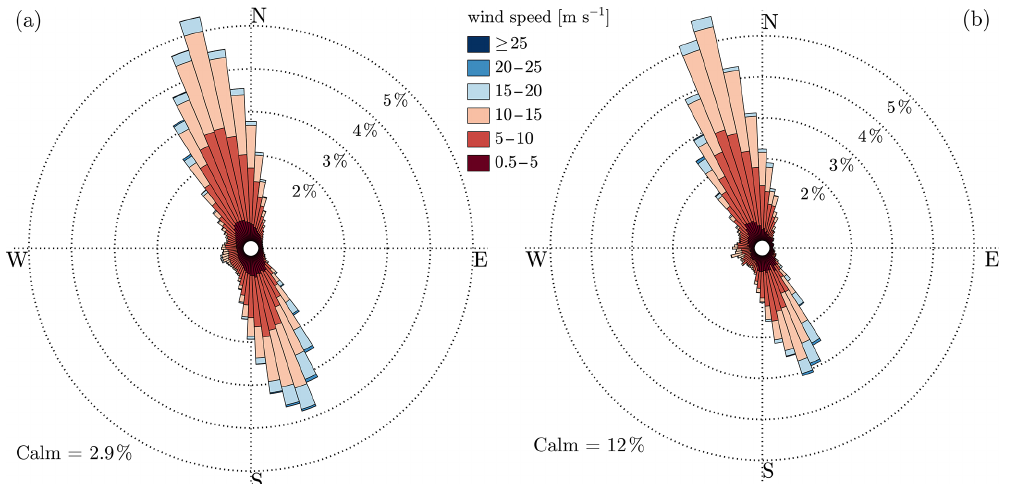
Figure 5. Wind roses of 10min wind speeds observed by MP5 at 118m for the reference period (2011–2019) (a) and during the EMP (b) . The calm threshold is 0.5ms − 1 . Each bin contains a 5 ◦ wind direction interval and circular grid labels indicate the percentage of occurrence.